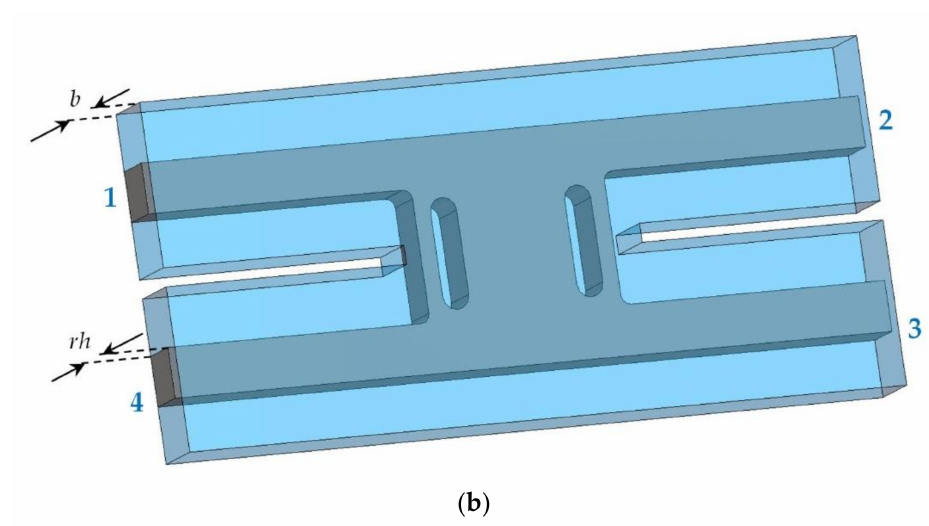
Figure 1. Hybrid coupler 1 (HC1) geometry. ( a ) Top view. ( b ) Three-dimensional view.